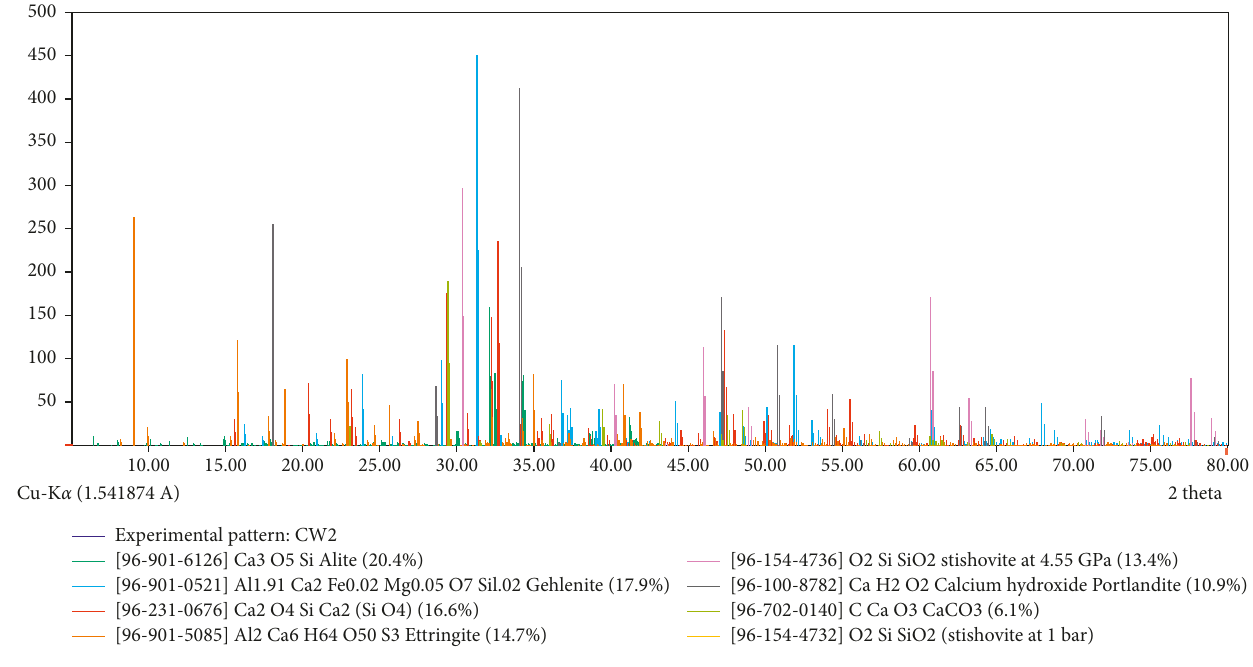
Figure 14: X-ray diffractogram of the mix CW2 at 28